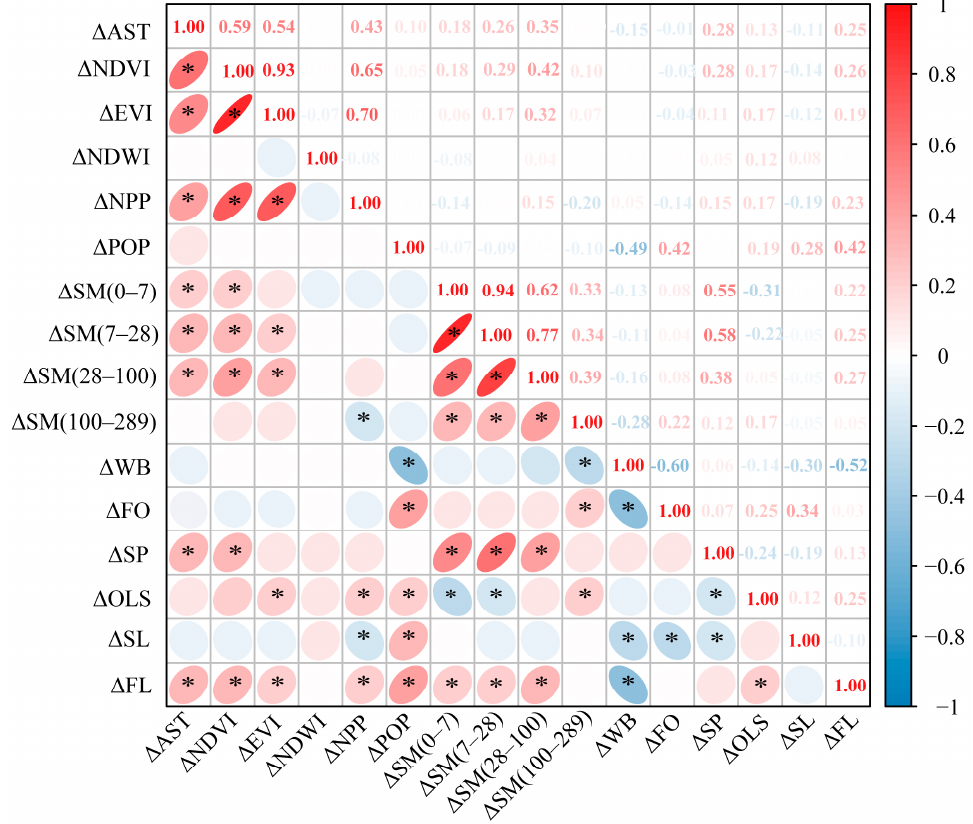
Figure 6. Spearman correlation analysis of ∆ AST in the UMRYR. The prefix ‘ ∆ ’ indicates the amount of interannual variation in the data. In particular, the symbol ‘*’ indicates that there is a significant relationship between the two variables ( p < 0.1). Refer to Table 1 for the abbreviated meanings of the variables.